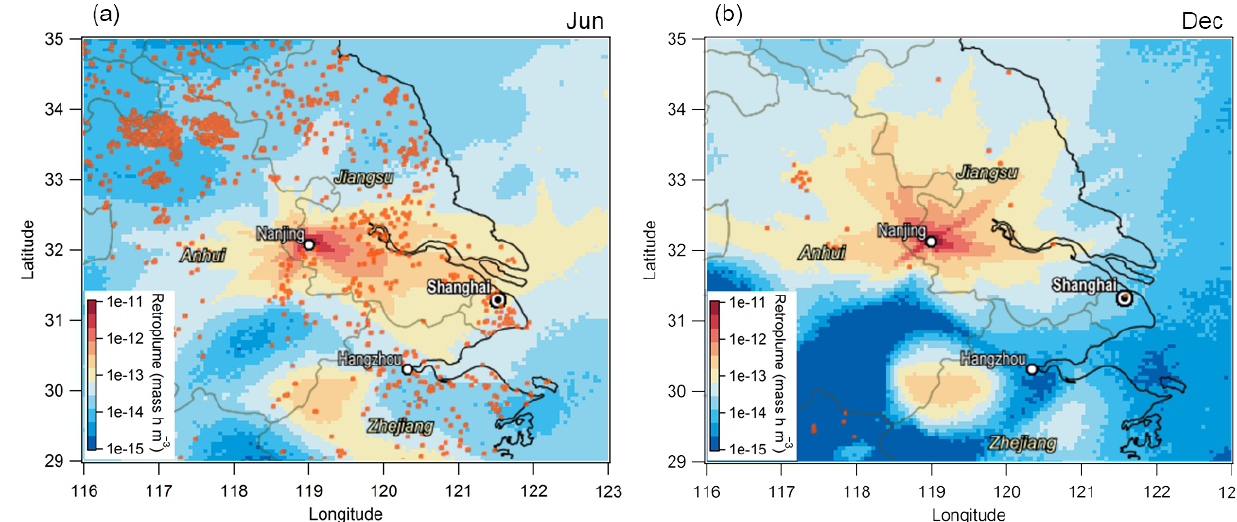
Figure 7. Map of averaged 3-day backward retroplume and the fire counts for (a) June and (b) December in 2014. Fire count data are from the MODIS Collection 6 Active Fire Product provided by the NASA fire mapper (https://firms.modaps.eosdis.nasa.gov/map/, last access: 20 October 2017).